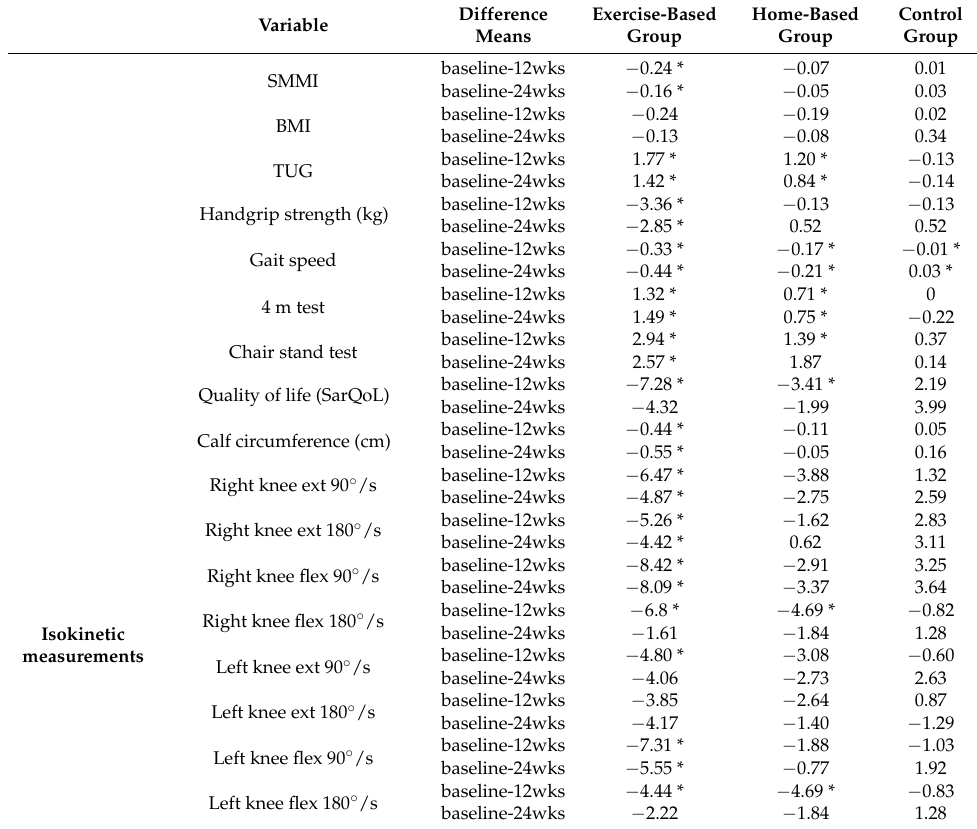
Table 4. Mean difference scores for each group across